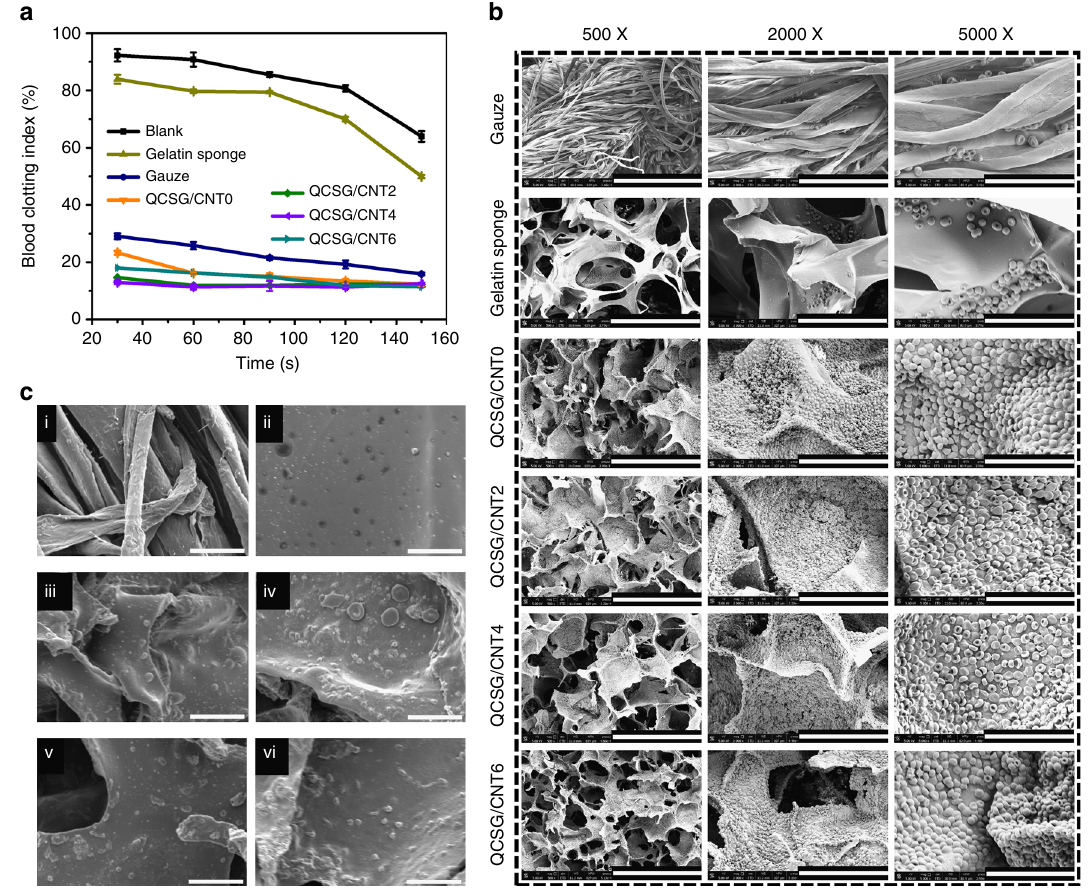
Fig. 6 In vitro hemostatic capacity evaluation of the cryogels. a In vitro dynamic whole-blood-clotting evaluation of the cryogels and controls. The blank group without any hemostatic agents showed the slowest blood-clotting speed and the highest BCI (blood-clotting index) after 150 s. Compared with blank group, gelatin sponge group showed more than a 14% decrease in BCI after 150 s ( P < 0.05), while gauze group showed signi fi cantly deceased BCI compared to gelatin sponge at each time point ( P < 0.001). b SEM images of hemocyte adhesion on the cryogels and controls. Scale bar: 300 µ m for ×500; Scale bar: 100 µ m for ×2000; Scale bar: 40 µ m for ×5000. c SEM images of platelet adhesion on the gauze (ci), gelatin hemostatic sponge (cii), QCSG/ CNT0 (ciii), QCSG/CNT2 (civ), QCSG/CNT4 (cv), and QCSG/CNT6 (cvi), respectively. Scale bar: 15 µ m. The error bars stand for s.e.m. ( n =